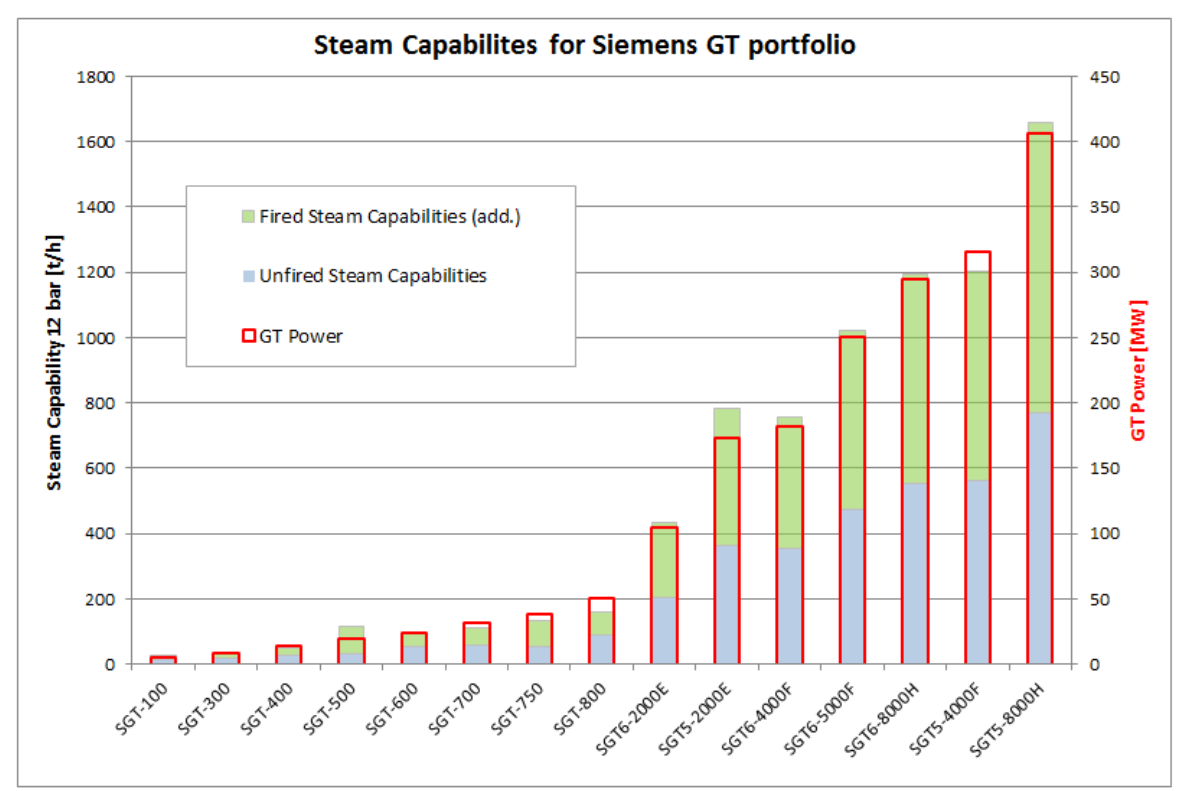
Figure 3. Steam capabilities for Siemens gas